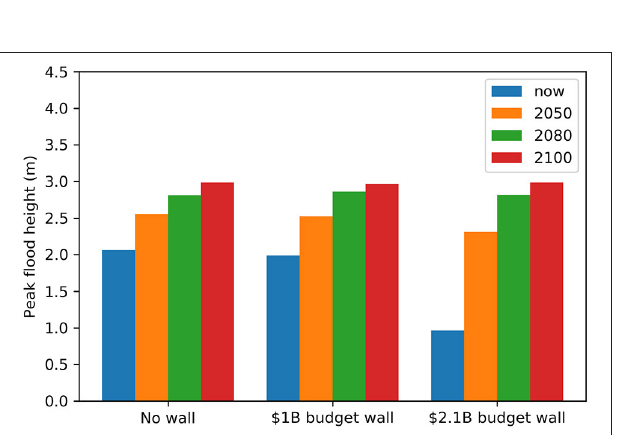
FIGURE 12 | A comparison of peak flood heights at the selected point in Lower Manhattan (identified by 1 in Figure 11 ) for different optimal protective measures and different levels of